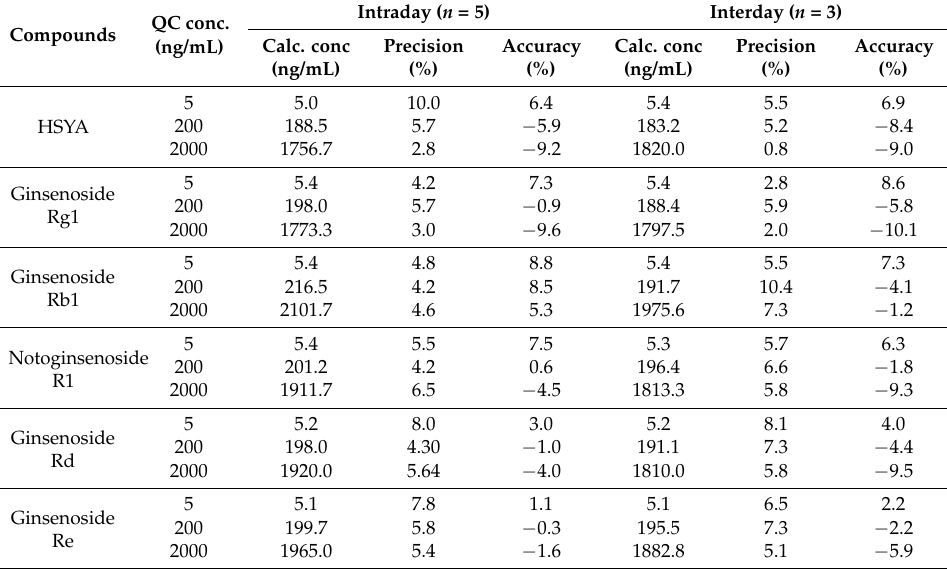
Table 4. Intra-/interday precision and accuracy of six compounds in feces.